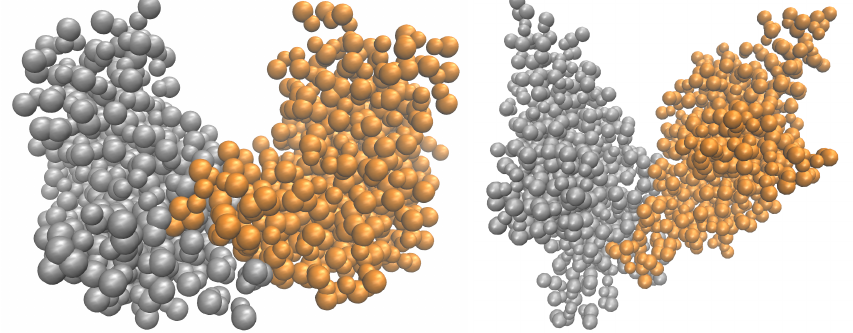
Figure 9. Visualization of two interacting HBcAg 2 obtained from the biased MD simulation with lowest potential A-B (side view left, top view